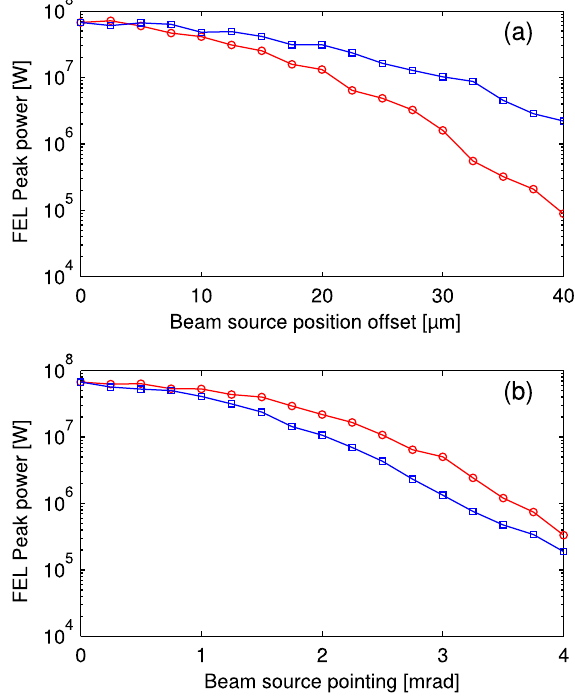
FIG. 10. Normalized FEL peak power at the undulator exit versus initial LPA beam (a) transverse position and (b) pointing (angle) in the (red circle) horizontal and (blue square) vertical plane. Beam transport simulation in the nonlinear case with BETA and sympletic 6D tracking without collective effects using the S2I-CM optics with r 11 ¼ r 33 ¼ 10 and r 56 ¼ 0 . 4 mm. FEL simulation with